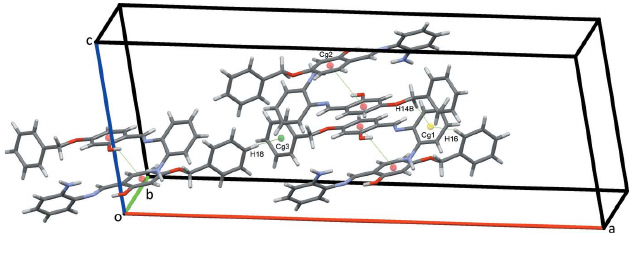
Figure 4 C—H (cid:3)(cid:3)(cid:3) (cid:2) and (cid:2) – (cid:2) conatcts (dotted green lines) in the crystal structure of (I).